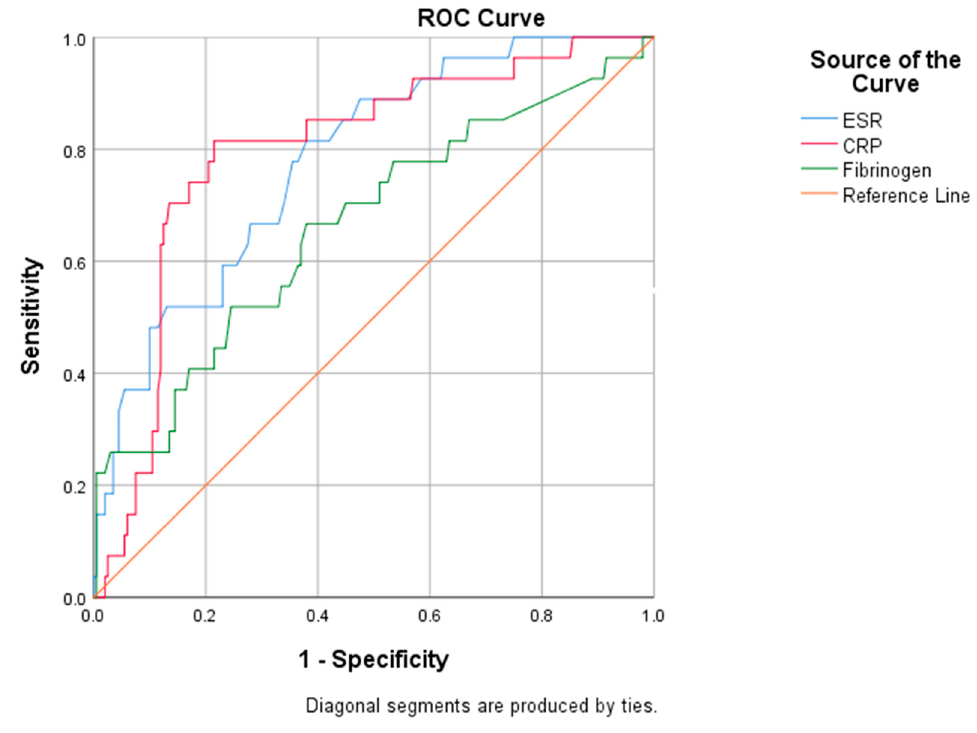
Table 9. AUC analysis: the biomarkers’ capacity in predicting